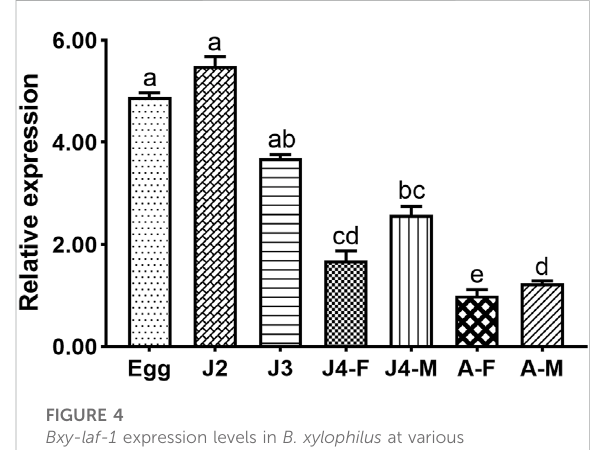
FIGURE 4 Bxy-laf-1 expression levels in B. xylophilus at various developmental stages were investigated using real-time quantitative PCR. The tbb-2 and β -actin endogenous reference genes were used to standardize the data. Adults were judged to have a 100% expression level. The same letter indicates that the difference between two groups is not signi fi cant, whereas distinct letters indicate that the difference between two groups has reached a signi fi cant level ( p < 0.05). The standard error of the mean is shown by the error bars. Adult, sexually mature worms; Egg, the embryo-stage; J2, the second-stage juveniles; J3, the third-stage juveniles; J4-F, the fourth-stage of female juveniles; J4-M, the fourth-stage of male juveniles; A-F, the adult stage of female juveniles; A-M, the adult stage of male juveniles.